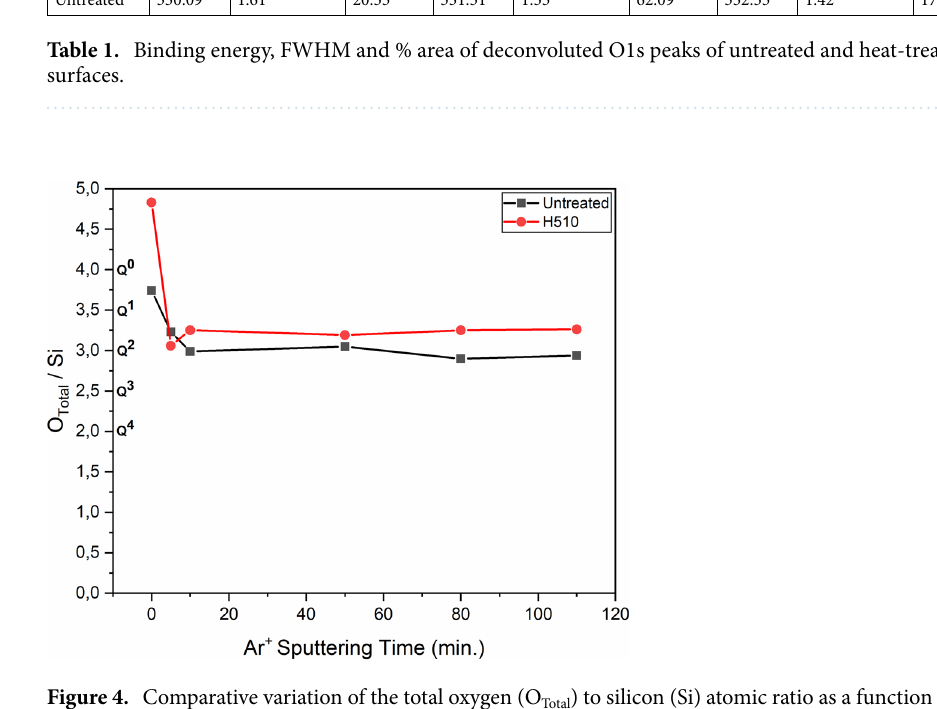
Figure 4. Comparative variation of the total oxygen (O Total ) to silicon (Si) atomic ratio as a function of Ar + sputtering time (depth range ~ 0–100 nm) for untreated and heat-treated specimens. The relative sensitivity factor (RSF) was taken into consideration. Connecting lines act as guideline to the